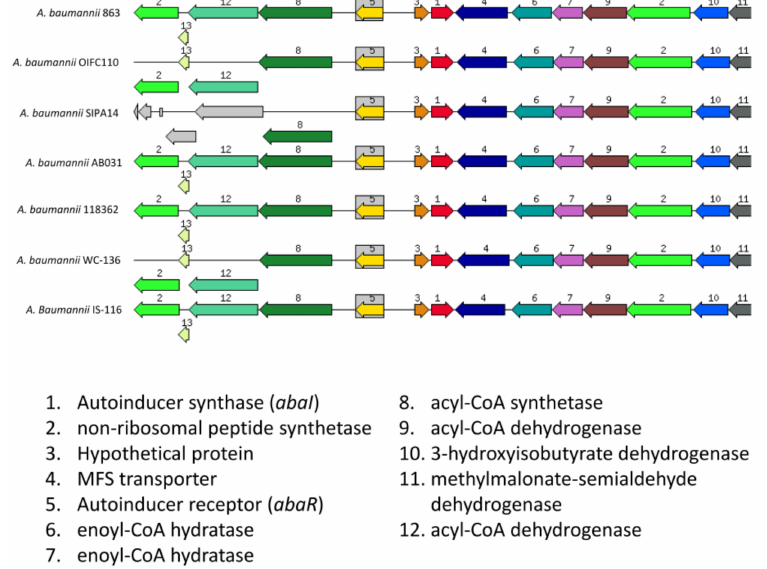
Figure 4. The organization of gene cluster of abaI . The organization of abaI in strain 863 and other A. baumannii strains.